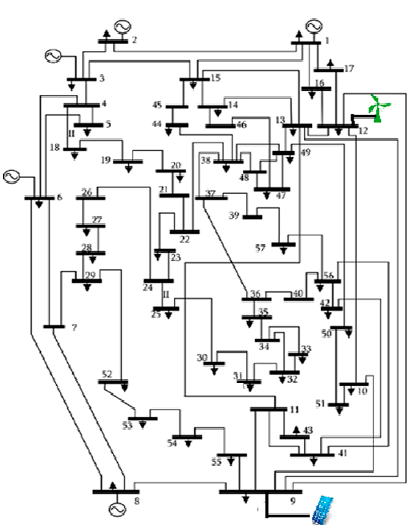
Figure A1. Integrated IEEE57 bus system with solar and wind.